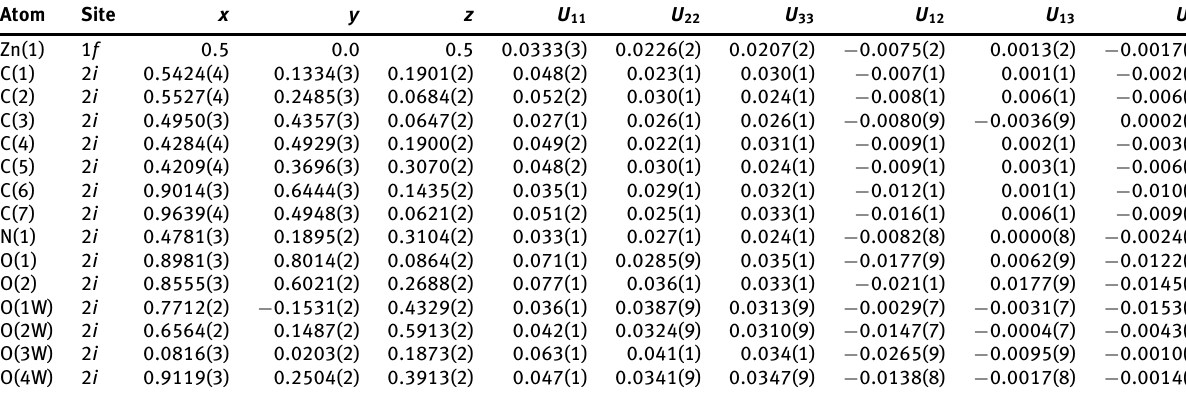
Table 3: Atomic displacement parameters (Å 2